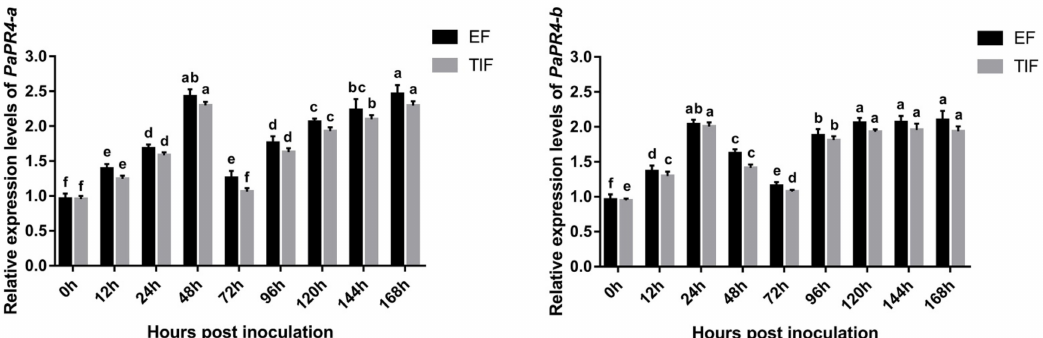
Figure 8. The expression levels of PaPR4-a and PaPR4-b at different durations after the infection of Pi. asperata with Lo. piceae . The relative expression levels represent the normalized mean ± standard deviation (SD) ( n = 3 biological replicates). The different letters indicate significant differences between samples determined by the Waller-Duncan test ( p <